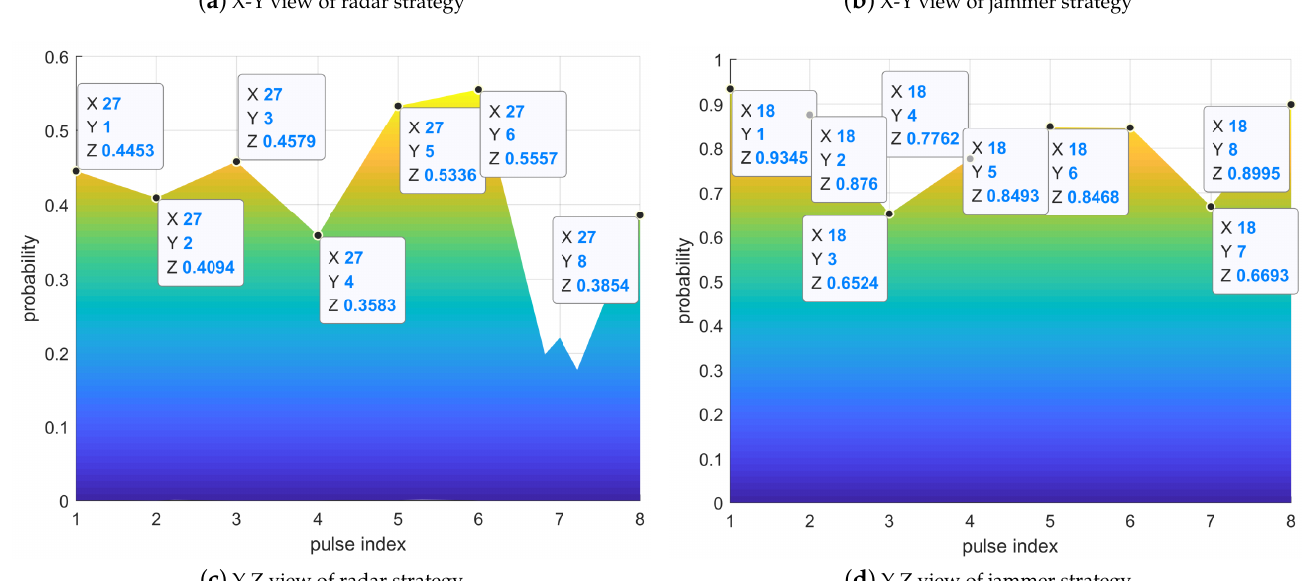
Figure 12. Approximate NE strategies with a quantization step of